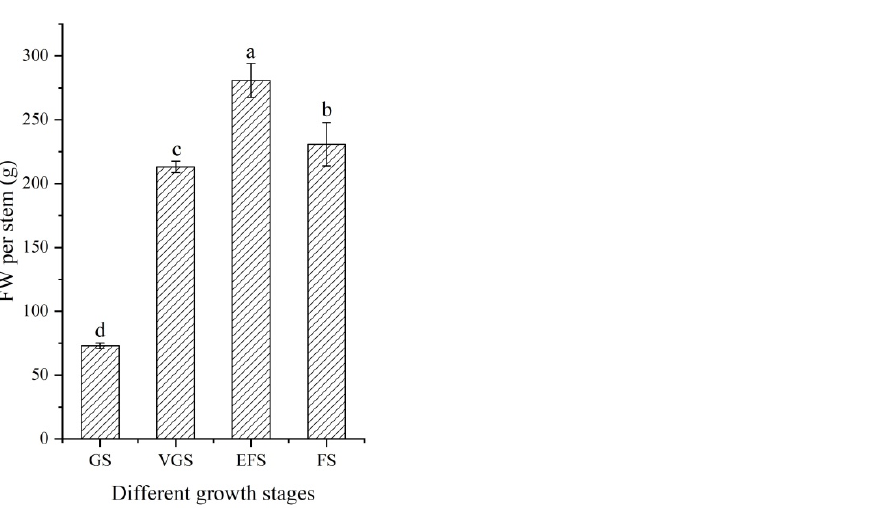
Figure 1. Stem fresh weight of C. songaricum at four different growth stages (mean ± SD, n = 10). Abbreviations: GS, germination stage; VGS, vegetative growth stage; EFS, early flowering stage; FS, flowering stage. Different letters represent a significant difference ( p < 0.05) at different growth stages.